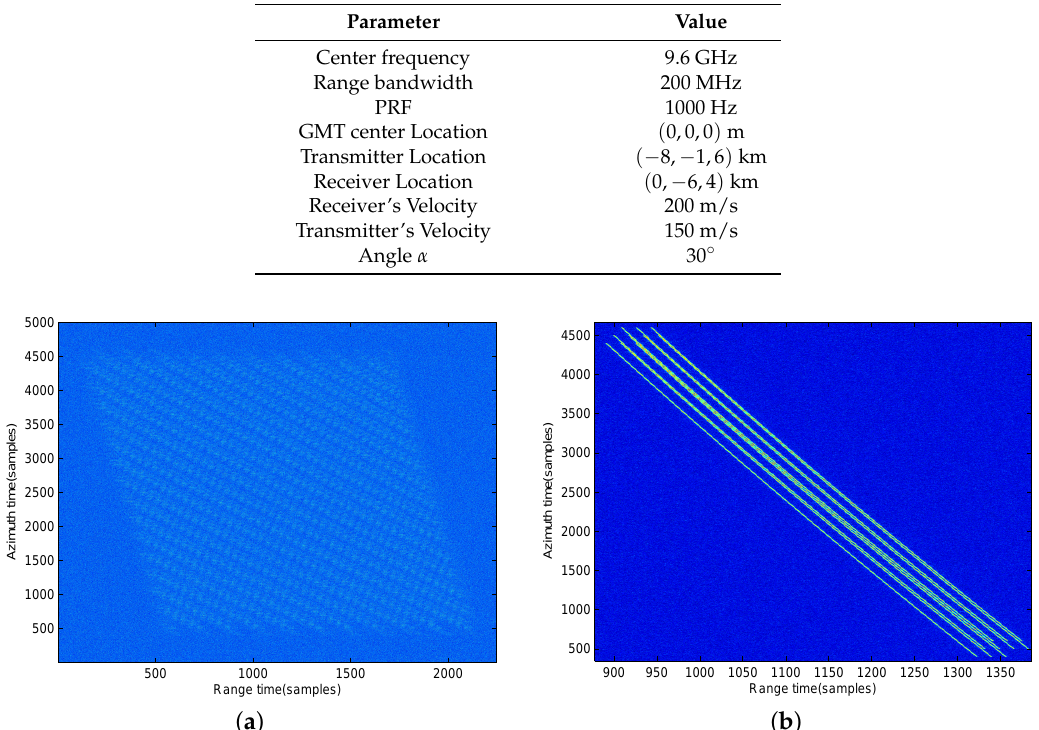
Figure 4. Raw date of the moving target for BFSAR. ( a ) In the 2-D time domain; ( b ) In the range-compressed domain.